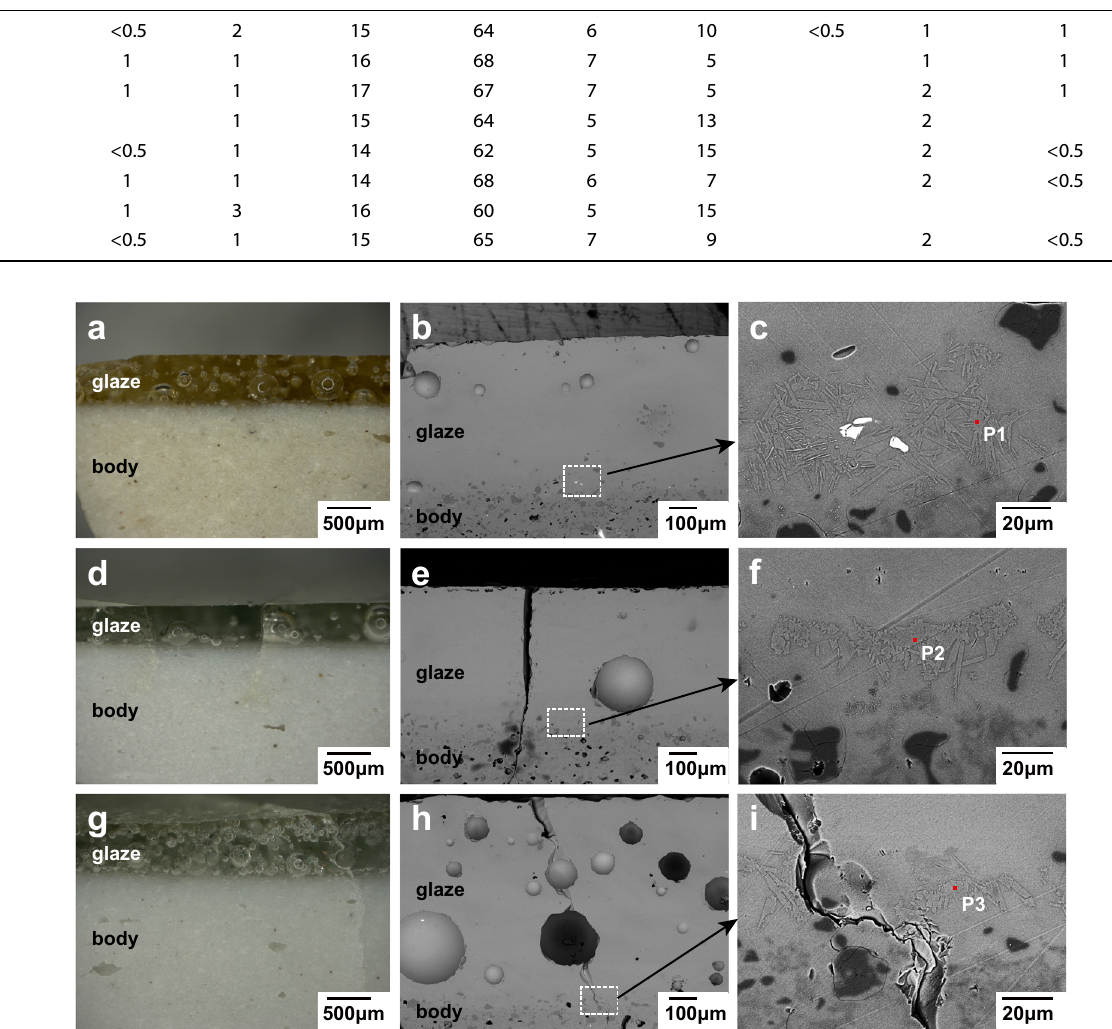
Table 1. Chemical compositions of the glass phase acquired on the cross section of the glaze by EDS (in wt%). Sample No.